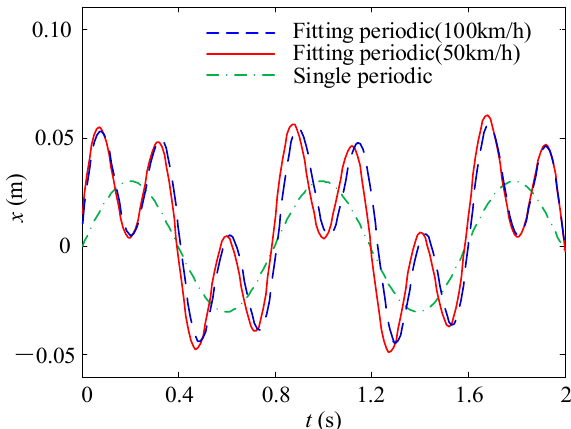
Figure 4. The fitting periodic road excitation model.